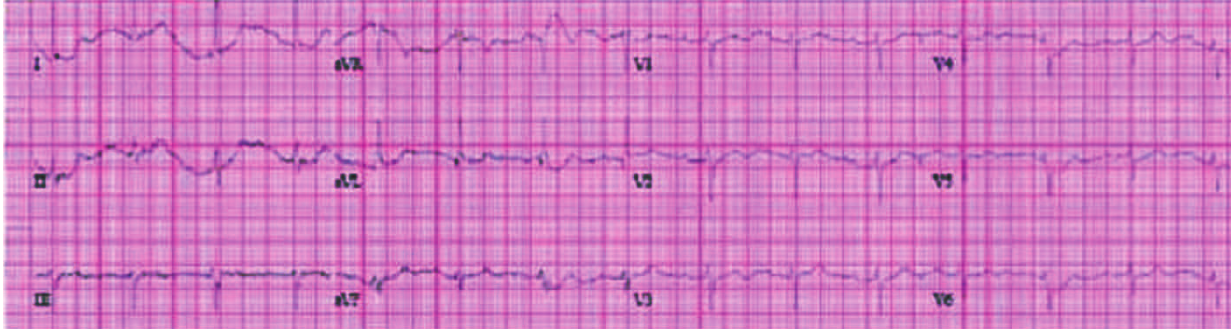
Fig. 2 - Postoperative electrocardiogram of patient 3 showing accelerated junctional rhythm 6 months after Maze procedure